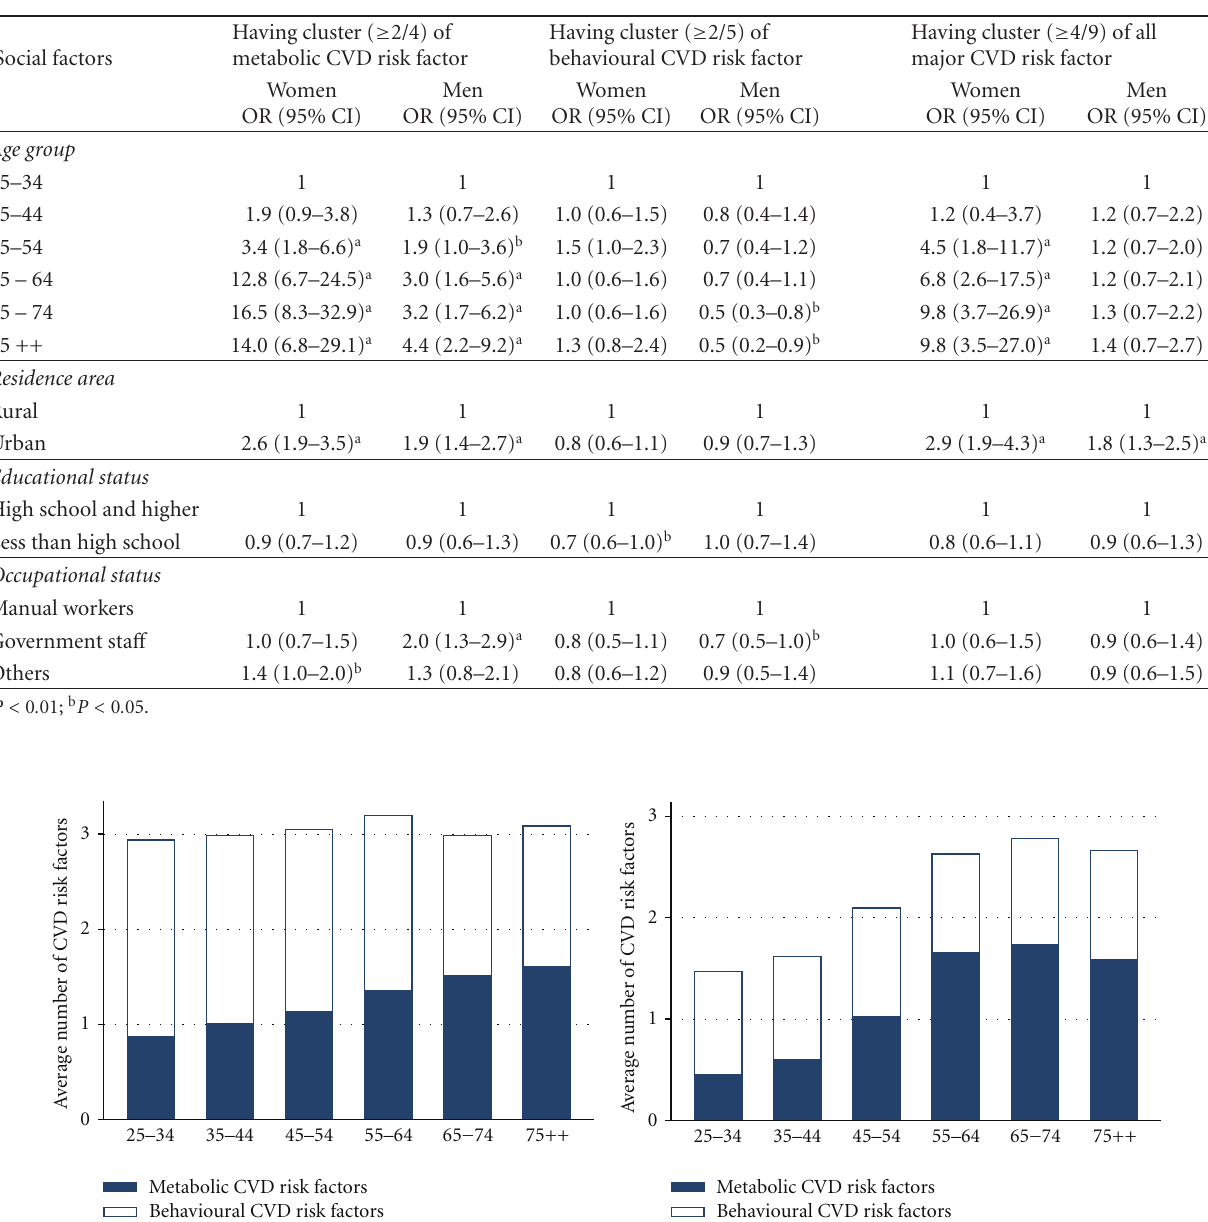
Table 4: Adjusted odds ratios (OR) with 95% confidence interval (CI) for having individually clustered CVD risk factors in a studied population of Vietnamese adults.